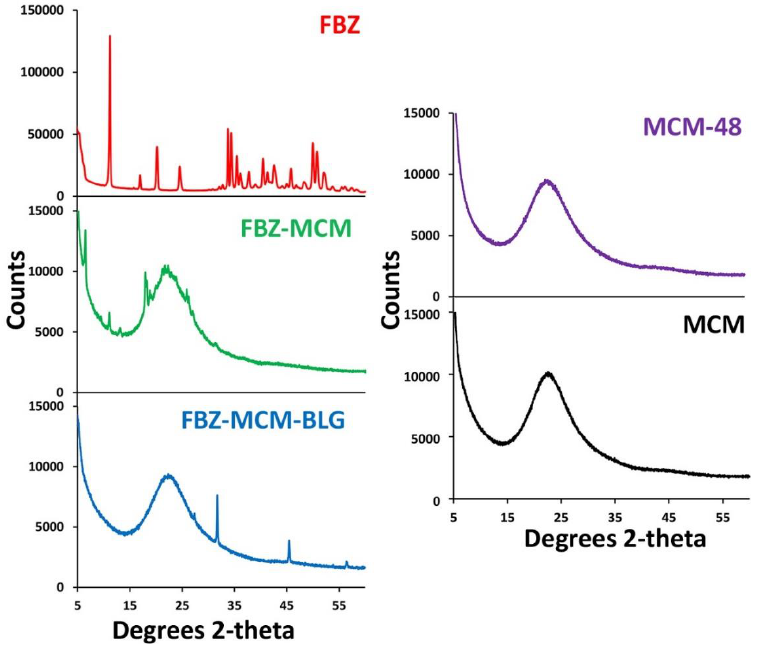
Figure 3. XRD pattern of the synthesized MCM-48, MCM, FBZ-MCM, and FBZ-MCM-BLG nano- particles.